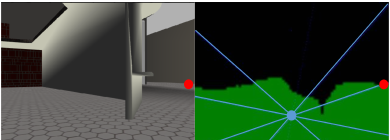
Figure 4. Example of goal point planning, the red point is the goal point and is projected to the raw image in the left